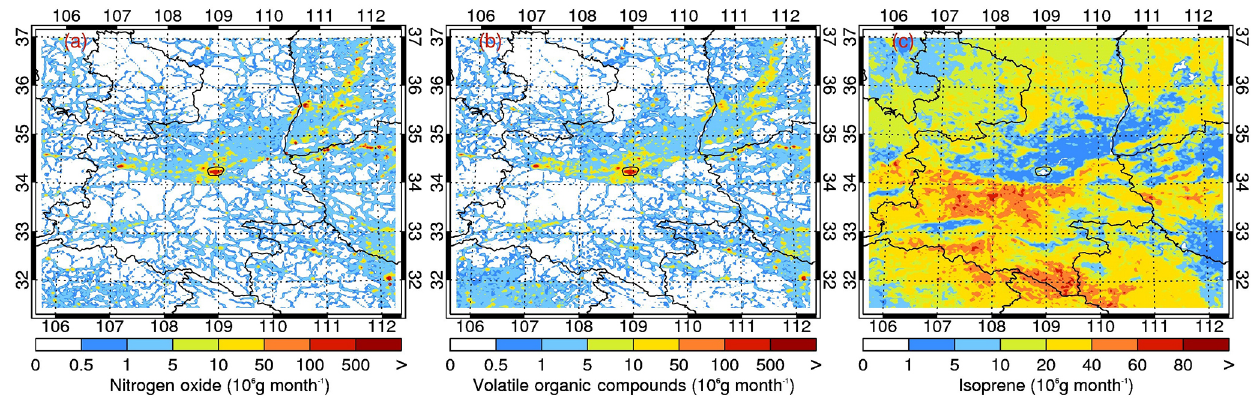
Figure 2. Geographic distributions of anthropogenic emissions of (a) nitrogen oxide, (b) volatile organic compounds, and (c) biogenic isoprene emission in the simulation domain. The black lines present provincial boundaries in China.